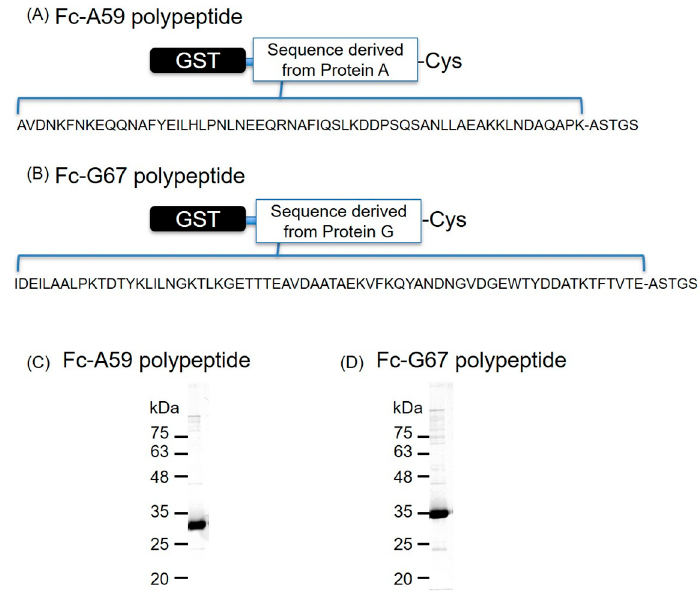
Figure 2. Design and purity of the Fc-binding polypeptide. ( A , B ) Schematic illustration and amino acid sequence of the Fc-binding polypeptides. ( C , D ) Confirmation of the purified polypeptides by SDS–PAGE.